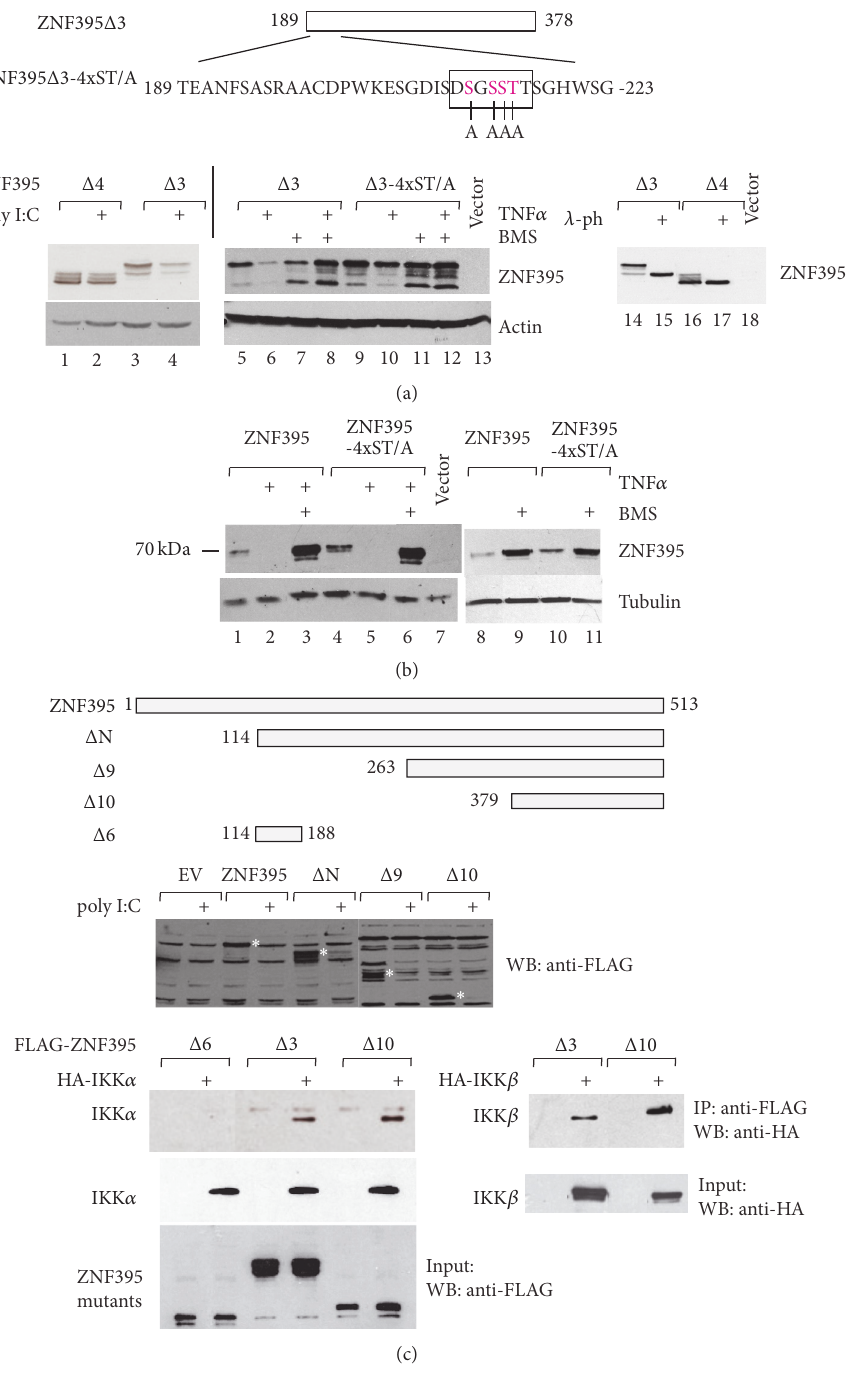
Figure 6: ZNF395 contains at least two independent IKK-dependent degradation motifs. (a) WB with extracts from RTS3b cells which have been transfected with vectors expressing two central fragments of ZNF395, Δ 3, encoding amino acids 189–378 and Δ 4, encoding amino acids 223–378, or Δ 3 with mutations within the putative phosphodegron (lanes 9–12) as indicated in the figure. The cells were treated with poly I:C (lanes 2, 4), TNF 𝛼 (lanes 6, 10), BMS-345541 (lanes 7, 11), or BMS-345541 and TNF 𝛼 (lanes 8 and 12) as indicated. In lanes 15–17 the extracts have been incubated with 𝜆 -phosphatase ( 𝜆 -ph) prior to analysis. The amino acid sequence from pos. 189–223 is given and the putative phosphodegron motif is indicated as well as mutations present in ZNF395 Δ 3 4xST/A or ZNF395 4xST/A. (b) RTS3b cells have been transfected with an expression vector for wt ZNF395 or ZNF395 4xST/A containing the mutations shown in (a) and treated with TNF 𝛼 and BMS-345541 as indicated. (c) Expression vectors for ZNF395 and deletion mutants, which are depicted in the figure, were transfected into RTS3b cells which have been incubated with pI:C 24 h prior to harvesting. The WB was developed with the FLAG antibody since the anti- ZNF395 antibody recognizes only an internal fragment of ZNF395 (data not shown). The lower part shows a coimmunoprecipitation with extracts from cells transfected with expression vectors for FLAG-ZNF395, HA-IKK 𝛽 , and HA-IKK 𝛼 . (EV = empty vector). ∗ indicates the position of the full length ZNF395